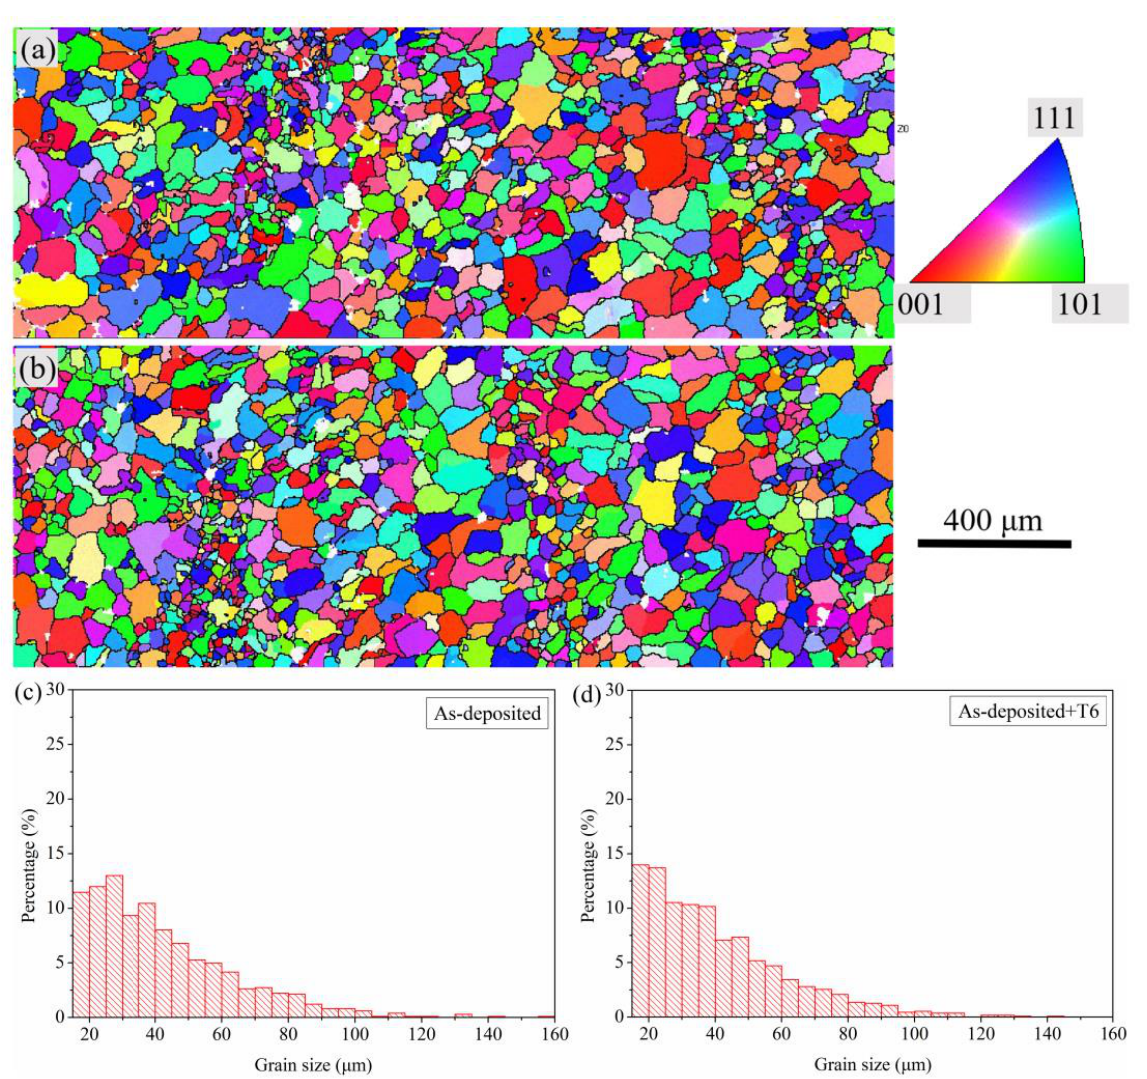
Figure 7. IPF orientation maps for ( a ) as-deposited and ( b ) T6 heat-treated alloy; statistics charts of grain size for ( c ) as-deposited and ( d ) T6 heat-treated alloy.